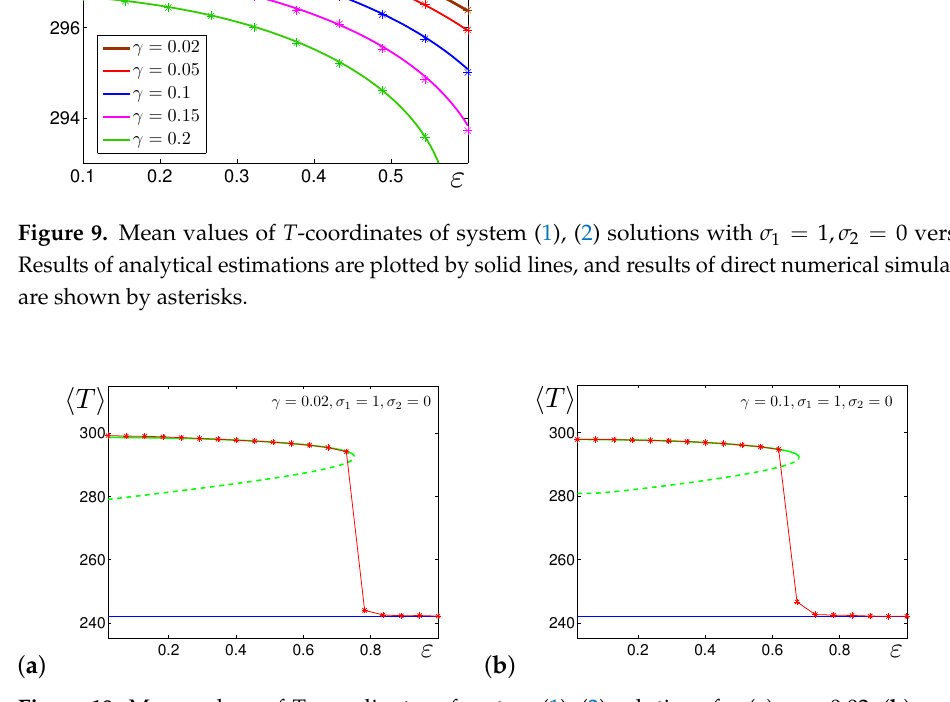
Figure 10. Mean values of T -coordinates of system (1), (2) solutions for ( a ) γ = 0.02, ( b ) γ = 0.1, for multiplicative noise with σ 1 = 1, σ 2 = 0. Results of analytical estimations are plotted by solid lines, and results of direct numerical simulations are shown by